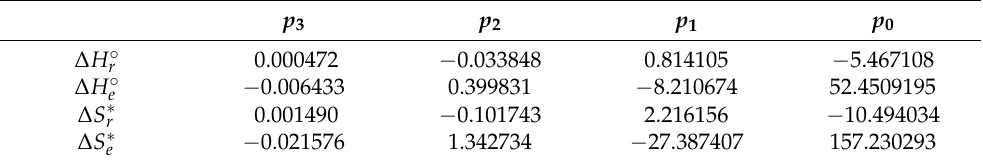
Table 2. Polynomial coefficients for interpolation of the thermodynamic parameters in Table 1 as func- tion of the acetonitrile content. Calculation in the form y = ∑ i p i · x i with y = ( ∆ H ◦ r , ∆ H ◦ e , ∆ S ∗ r , ∆ S ∗ e ) and x as ACN content in vol%. Enthalpies in kJ/mol and entropies in J/(mol K). p 3 p 2